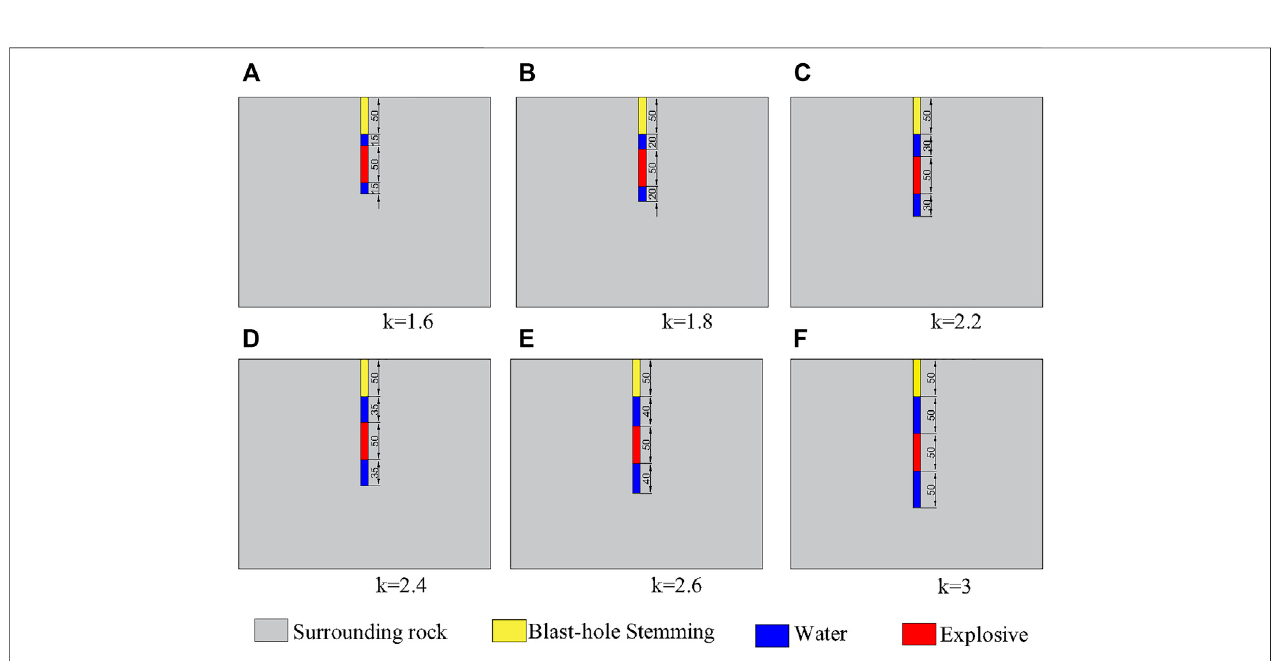
FIGURE 11 | Model diagram of different axial decoupling coef fi cients (unit: cm). (A) k = 1.6, (B) k = 1.8, (C) k = 2.2, (D) k = 2.4, (E) k = 2.6, (F) k = 3.